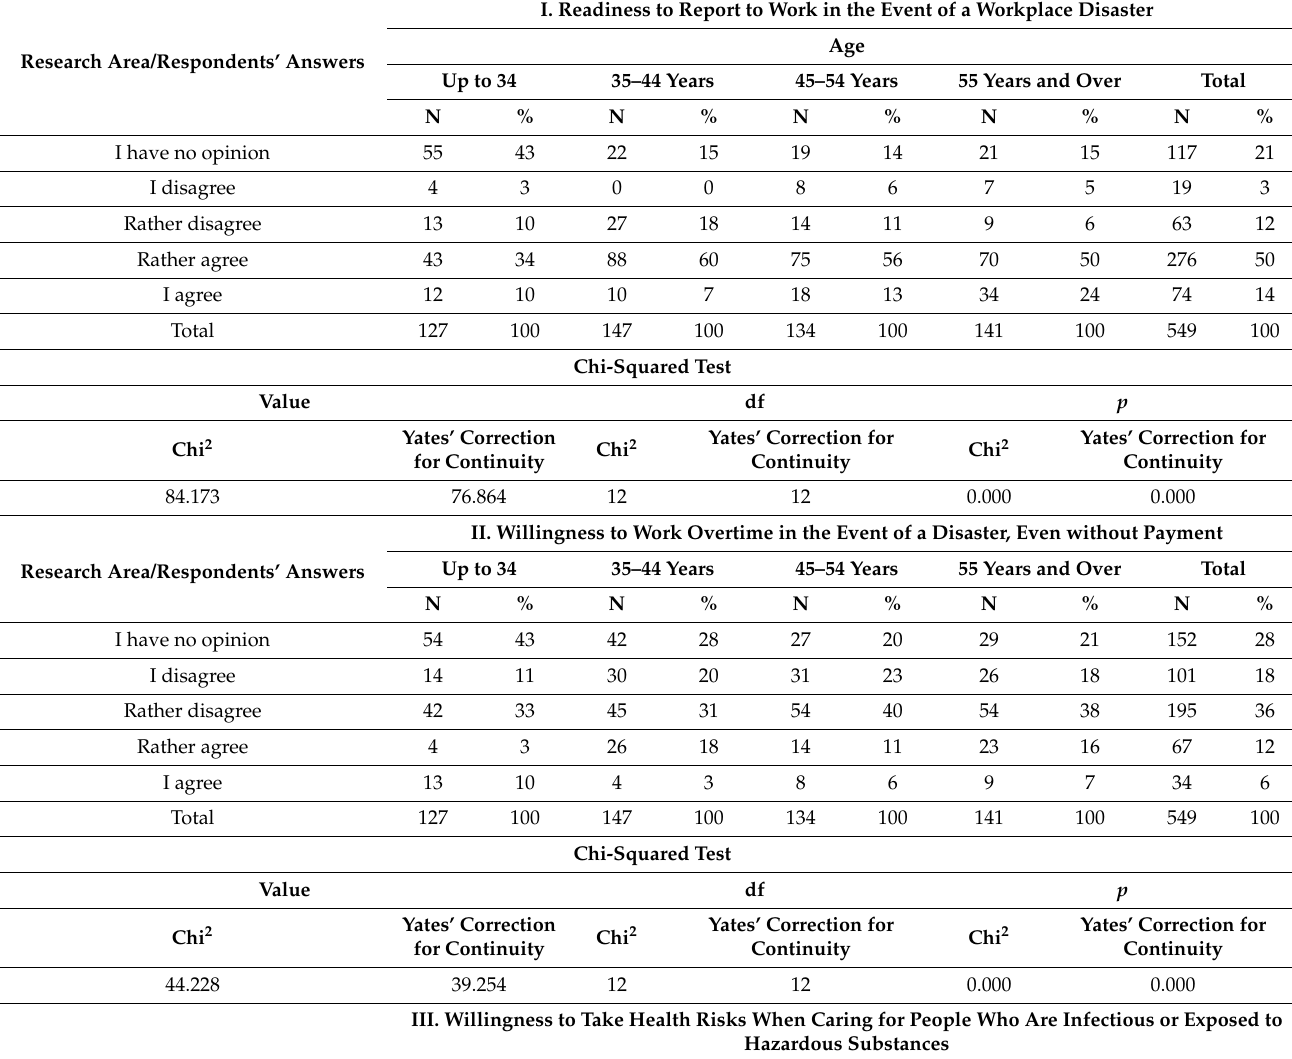
Table 2. Research areas and the age of